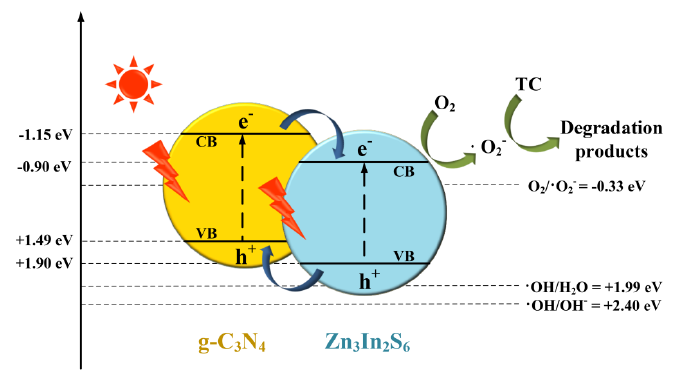
Figure 13. The proposed photocatalytic mechanism for photocatalytic degradation of TC on Zn 3 In 2 S 6 /g-C 3 N 4 .